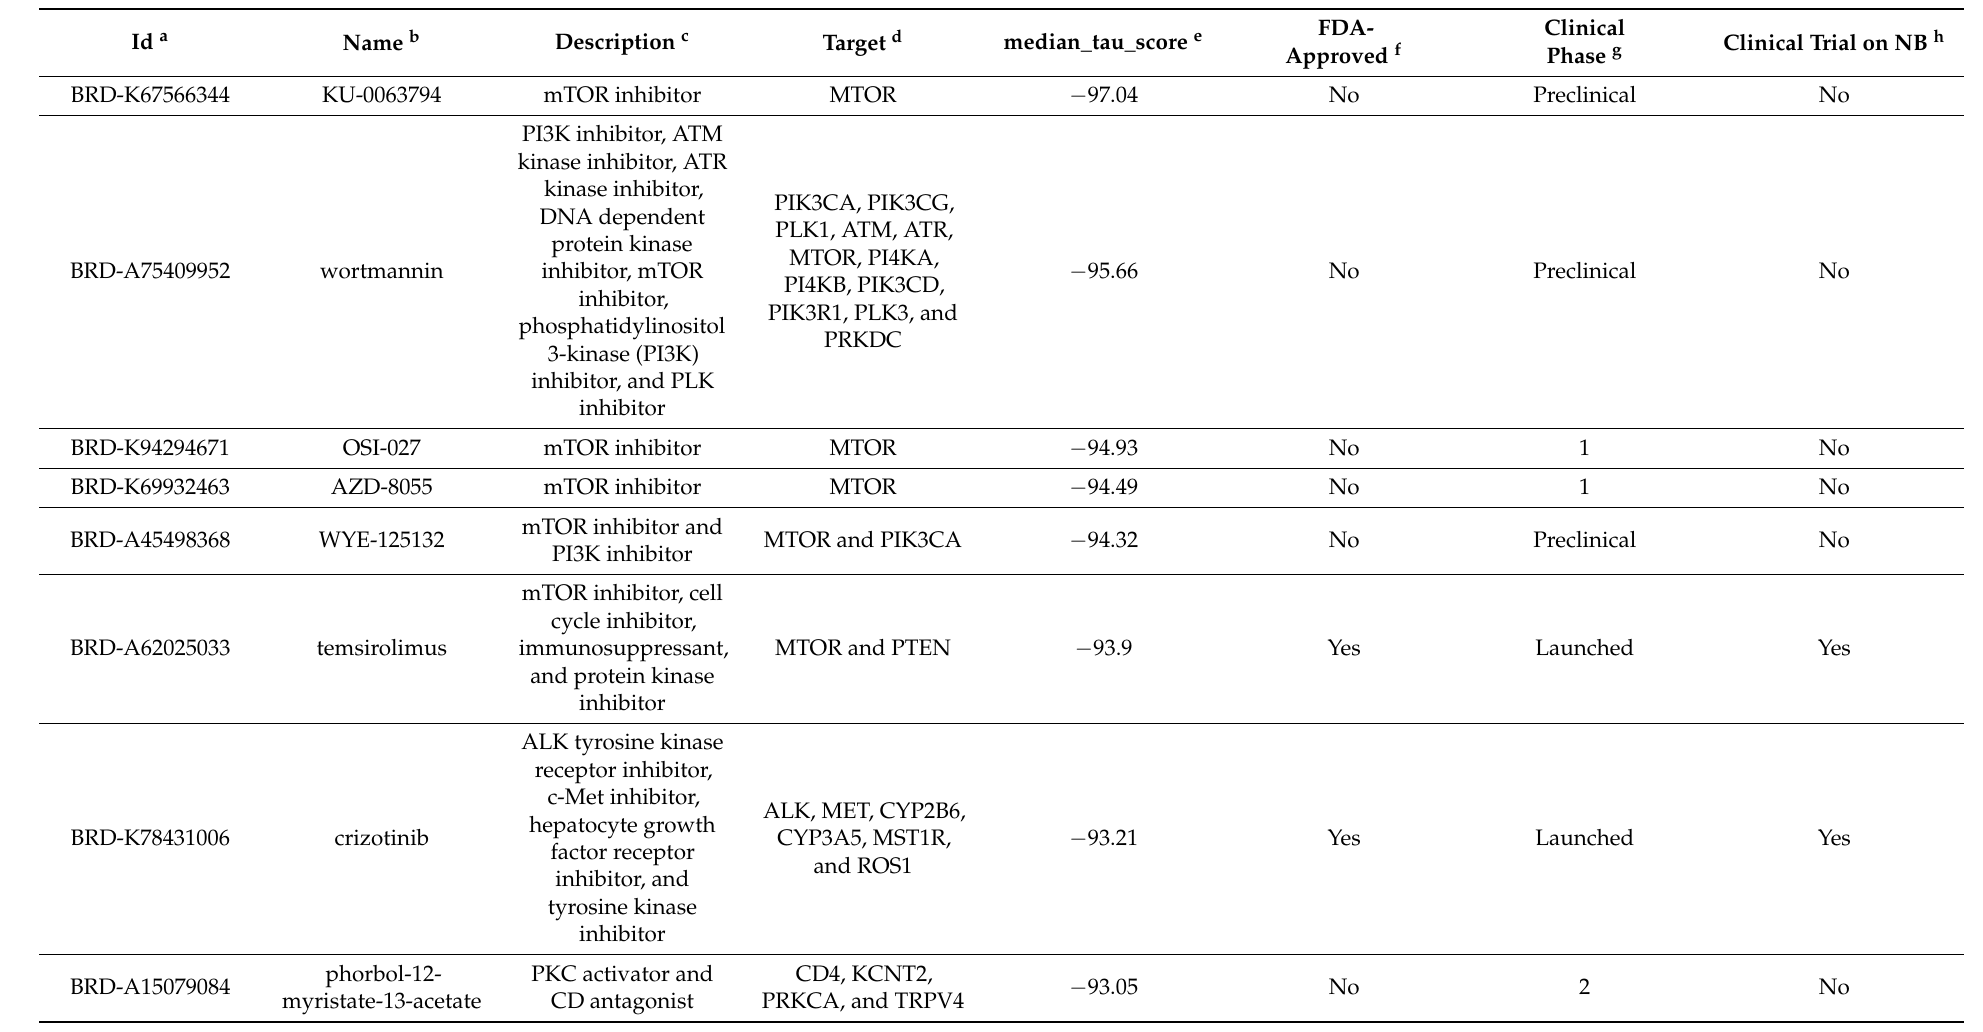
Table 1. New candidate CMap compounds potentially targeting hypoxia-modulated genes in